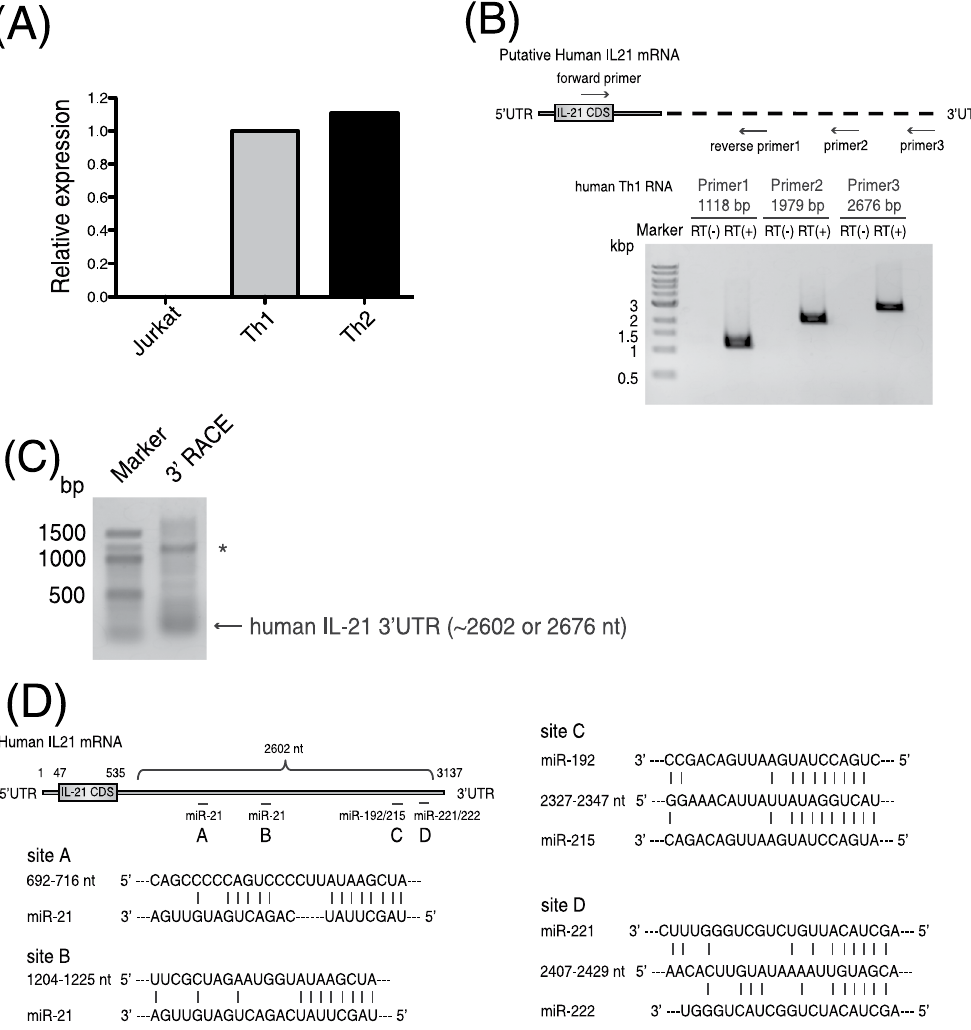
Figure 2. Long 3 ′ UTR of human IL-21 mRNA was identified from human T cells. ( A ) Relative expression level of IL-21 mRNA was examined by quantitative real-time RT-PCR. Data shown are a representative of three independent experiments performed. Bars indicate the means of triplicates. ( B ) RT-PCR was performed with RNA from human Th1 cells to detect human IL-21 mRNA. Revere primers were designed in putative regions of 3 ′ UTR of human IL-21 mRNA. One representative data of three experiments is shown. ( C ) The 3 ′ end of human IL-21 mRNA was identified by the 3 ′ RACE experiment. The forward primer was designed to anneal to the 2463–2484 nt of the 3 ′ UTR. Asterisk indicates a non-specific band. ( D ) The identified 3 ′ UTR of human IL-21 mRNA and its conserved target sites of the EV-miRNAs are illustrated.